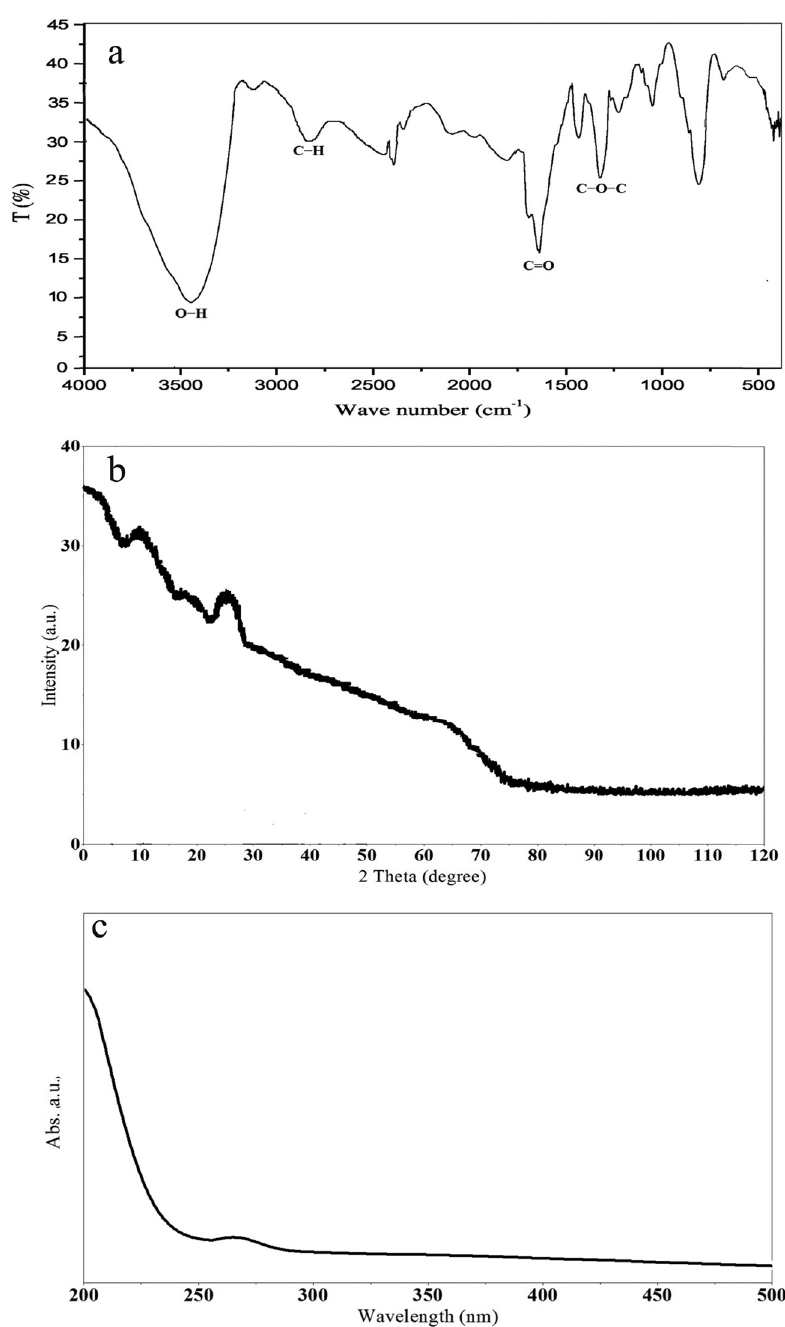
Figure 1: FT - IR spectrum ( a ) , XRD pattern ( b ) , and UV - Vis absorption ( c ) of